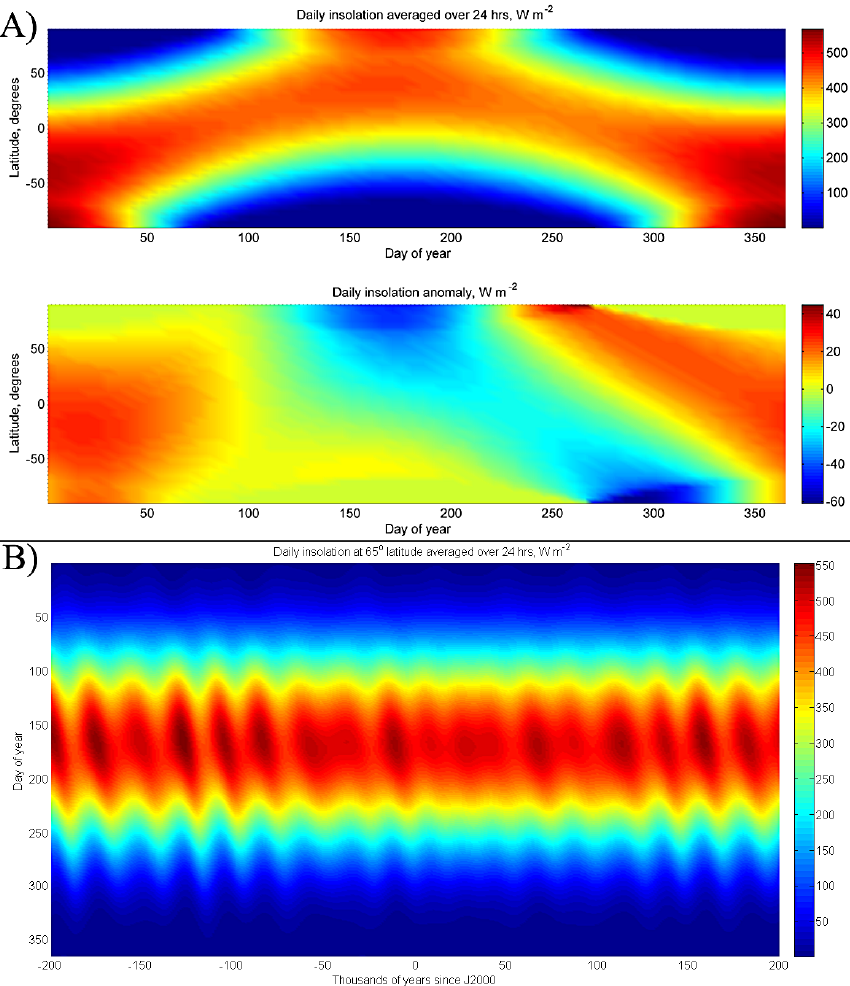
Figure 3. (A) A day of year-latitude insolation plot for 115kyr before present (J2000) (upper panel) and the corresponding anomaly from J2000 (lower panel), using S o = 1366Wm − 2 . (B) Insolation time series at 65 ◦ N as a function of day of year, spanning 200kyr before and after present (J2000). Negative years are in the past. Both (A) and (B) use the La2004